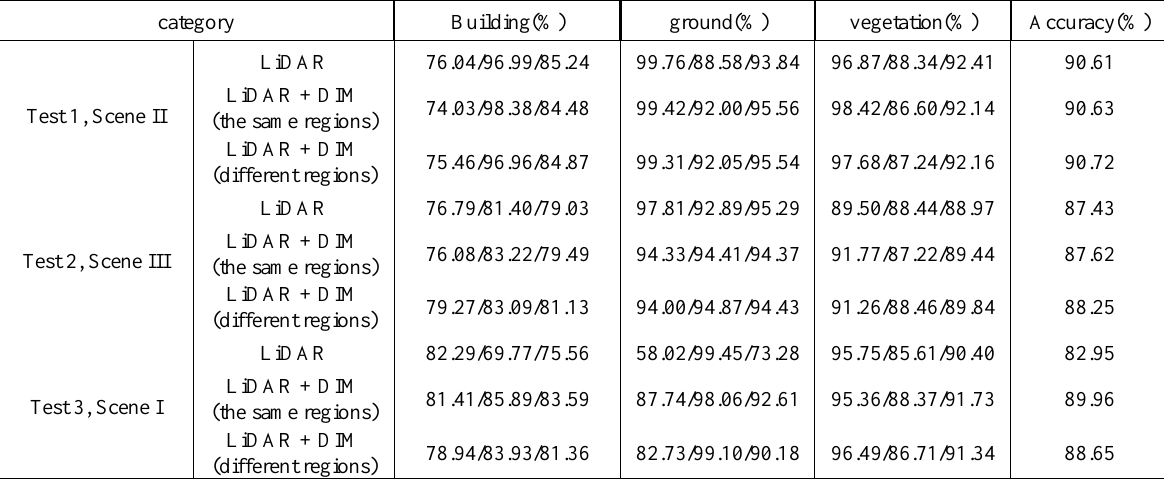
Table 4. Precision/recall/F1score and accuracy of both using the LiDAR points and both LiDAR points and DIM points (at the same regions and different regions) based on the super-voxel-based classification